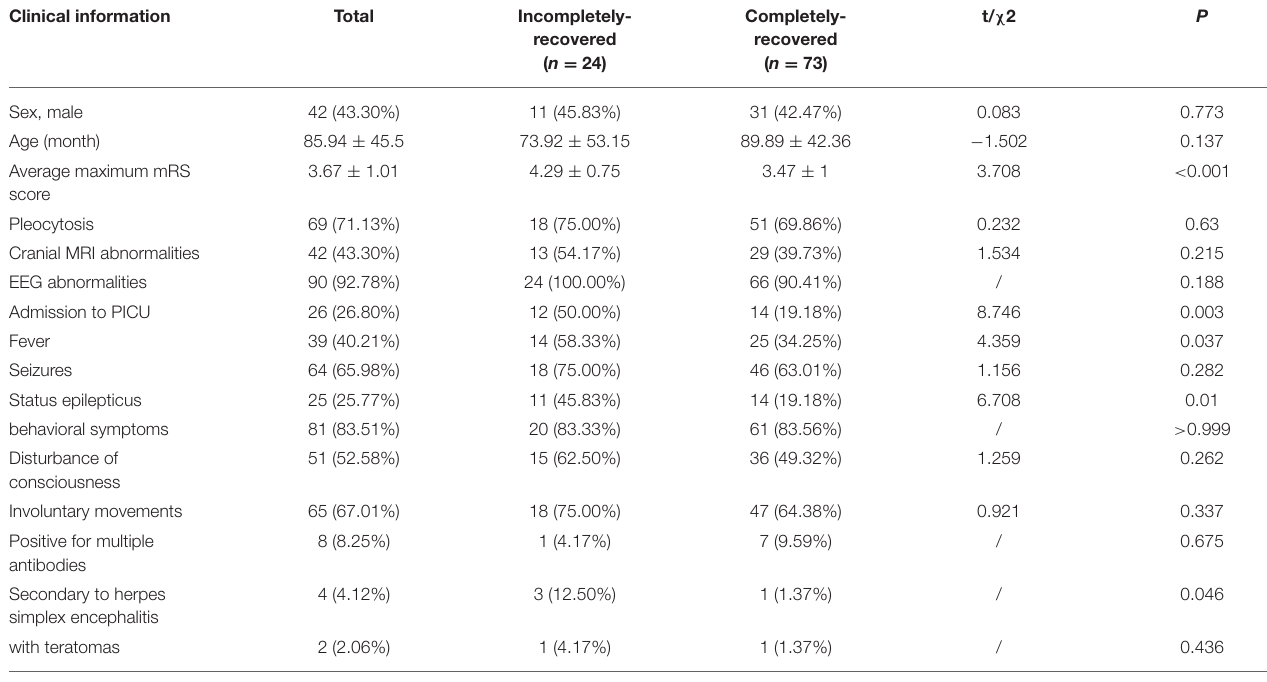
TABLE 5 | Comparison of clinical data of patients with anti-NMDAR encephalitis between the completely-recovered and incompletely-recovered groups, case (%). Clinical information